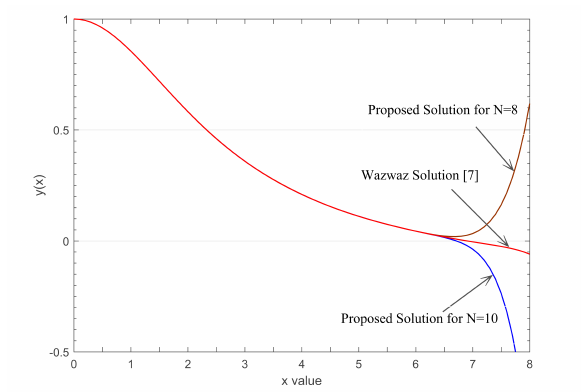
Fig. 3: Plot of obtained solution y(x) for N = 8, N = 10 and series solution presented by Wazwaz [7] for example